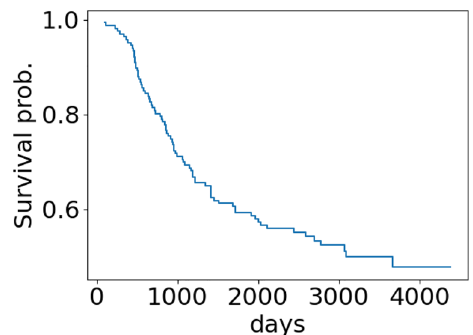
Figure 1. The Kaplan survival curve of PBLL patients.